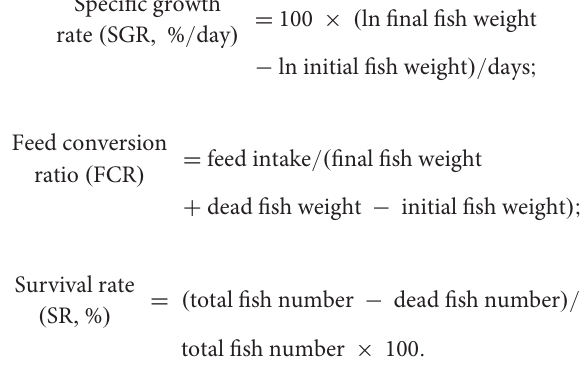
TABLE 1 | Ingredients and nutrient contents of the